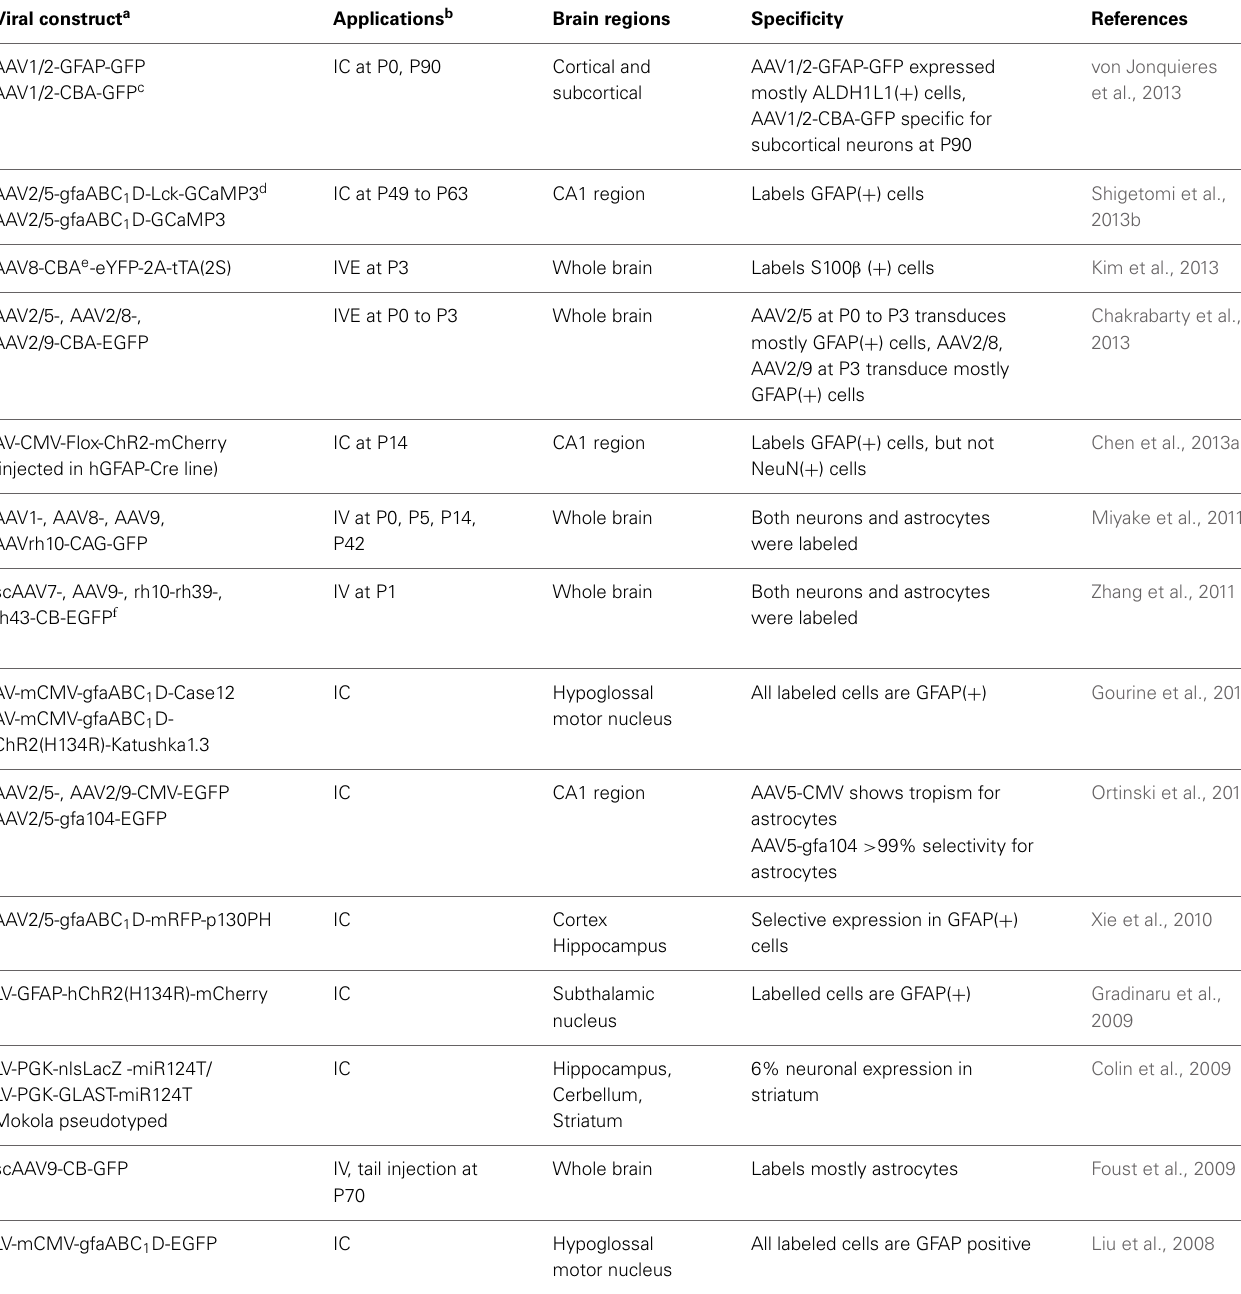
Table 1 | Viral constructs for specific targeting mouse